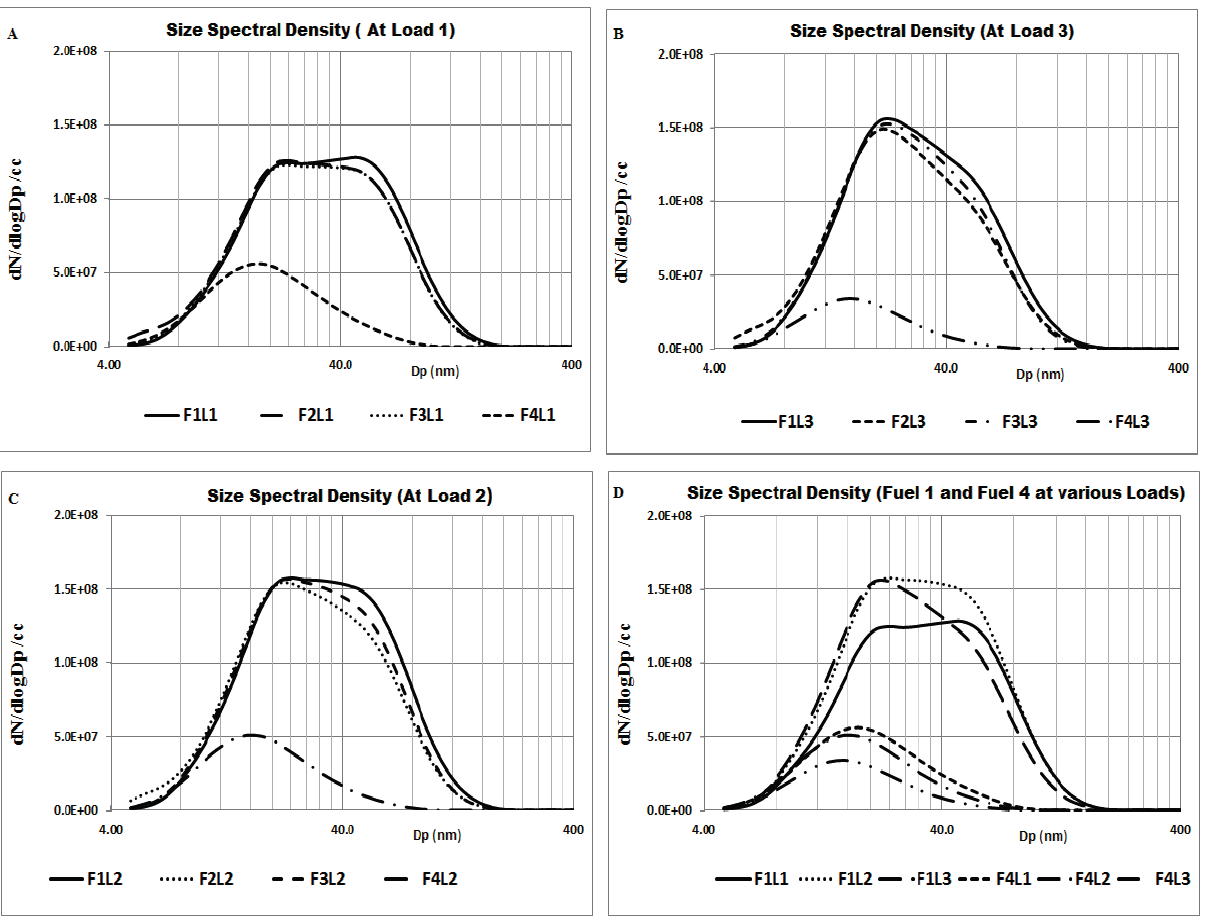
Figure 10. Comparison of particulate emissions at different